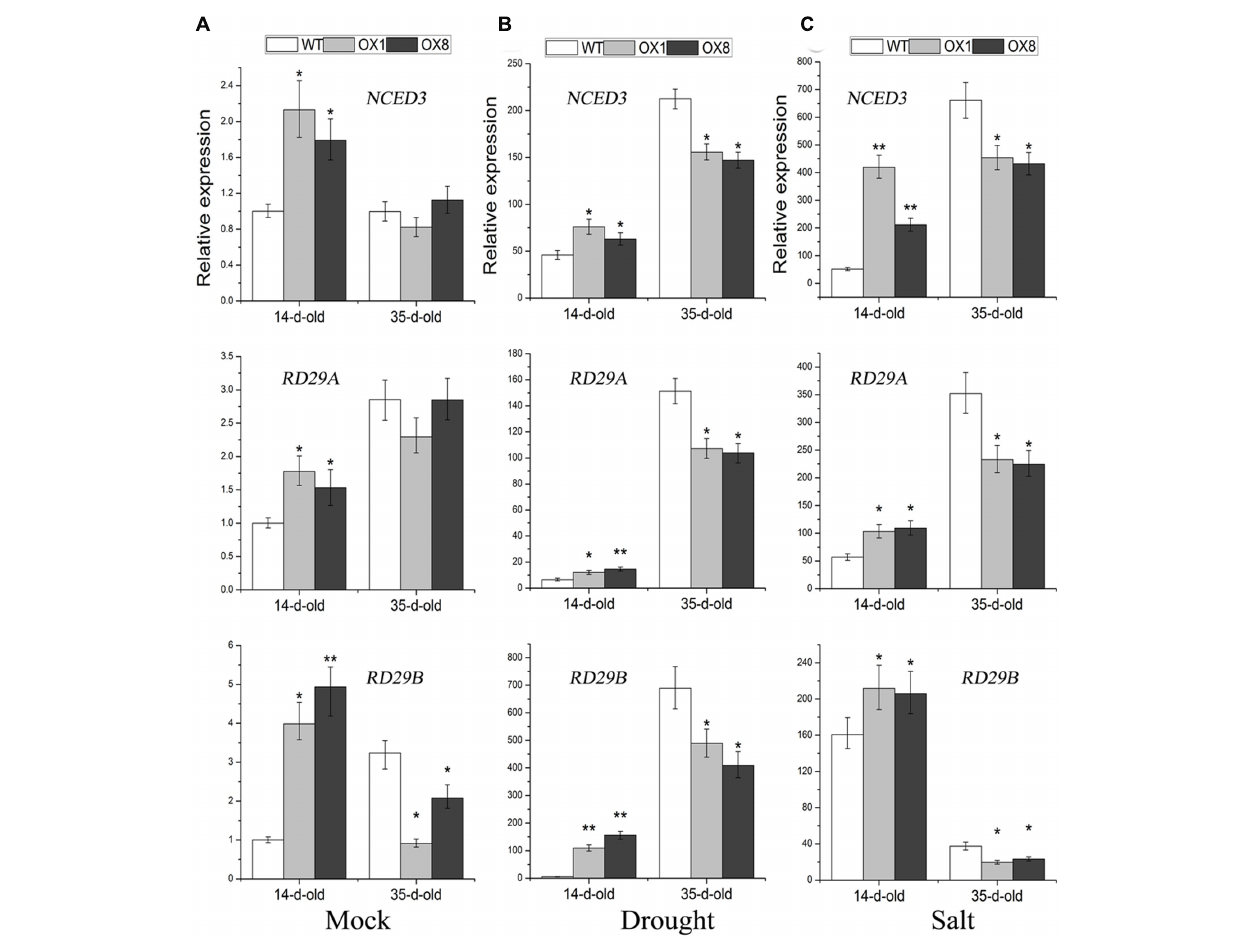
FIGURE 7 | Expression pattern of NCED3 , RD29A and RD29B in WT and TaNAC2D -OX plants. The 14-day-old seedlings grown on 1/2 MS medium were subsequently submerged in 1/2 MS liquid cultures supplemented with 200 mM NaCl for 6 h or placed on dry filter paper, and then dehydrated for 1 h. Moreover, the 35-day-old soil-grown plants were incubated for 6 h in 200 mM NaCl solution or dehydrated for 3 h. Transcript levels were determined by qRT-PCR and normalized to actin2 . The values in 14-day-old untreated WT plants were set to 1. Data are means ± SE of three biological replicates. Asterisks indicate significant differences from WT ( ∗ P < 0.05; ∗∗ P < 0.01). (A) Effects of normal growth. (B) Effects of drought stress. (C) Effects of salt